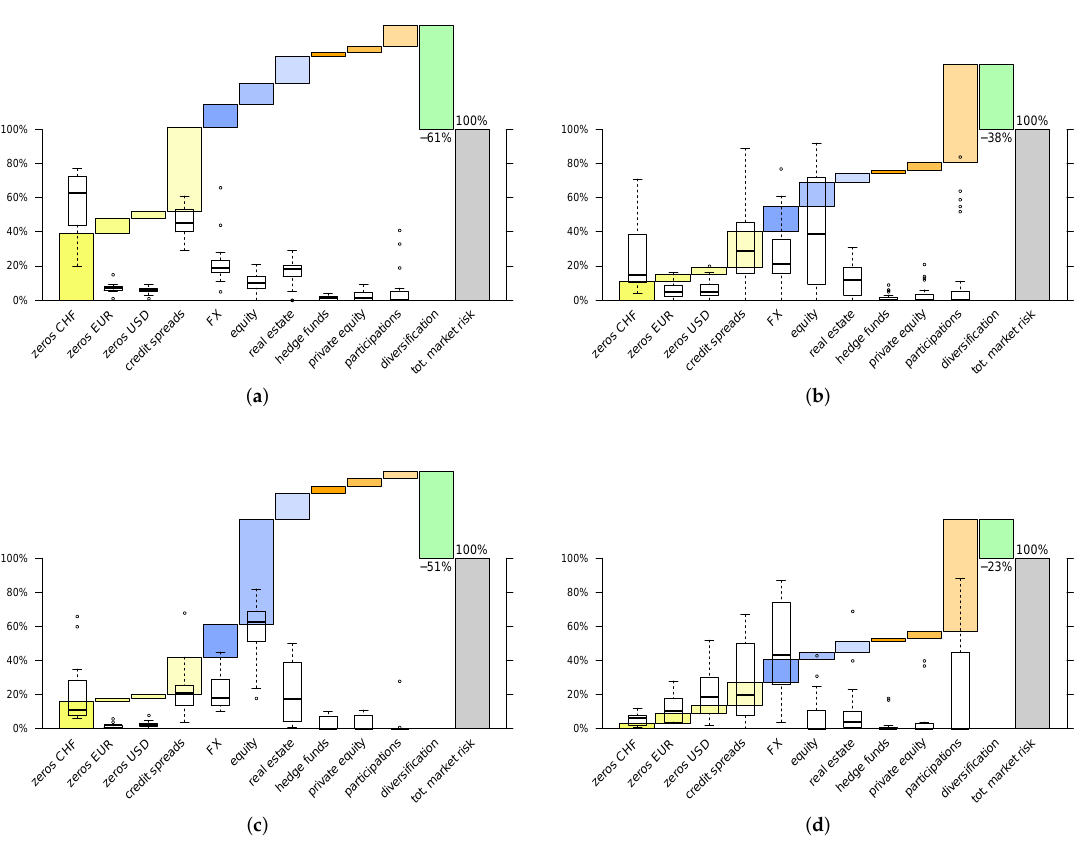
Figure 4. Market risk analysis of the CHF insurance market based on the Swiss Solvency Test (SST) guidelines. On the level of a single company, this analysis provides the contributions of selected market risk factors to the total market risk. Each box plot considers all companies in a given branch of insurance individually. The superimposed waterfall diagram illustrates weighted averages over all companies in a given branch of insurance. These diagrams also show the weighted average diversification effect for each branch of insurance. ( a ) life insurance; ( b ) general insurance; ( c ) health insurance; ( d )